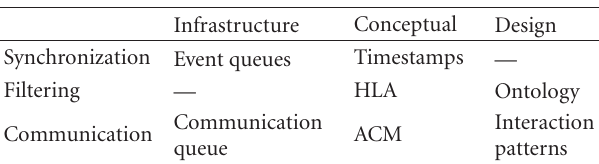
Table 1: Contribution of each stance to the three challenges of connecting agents to games.